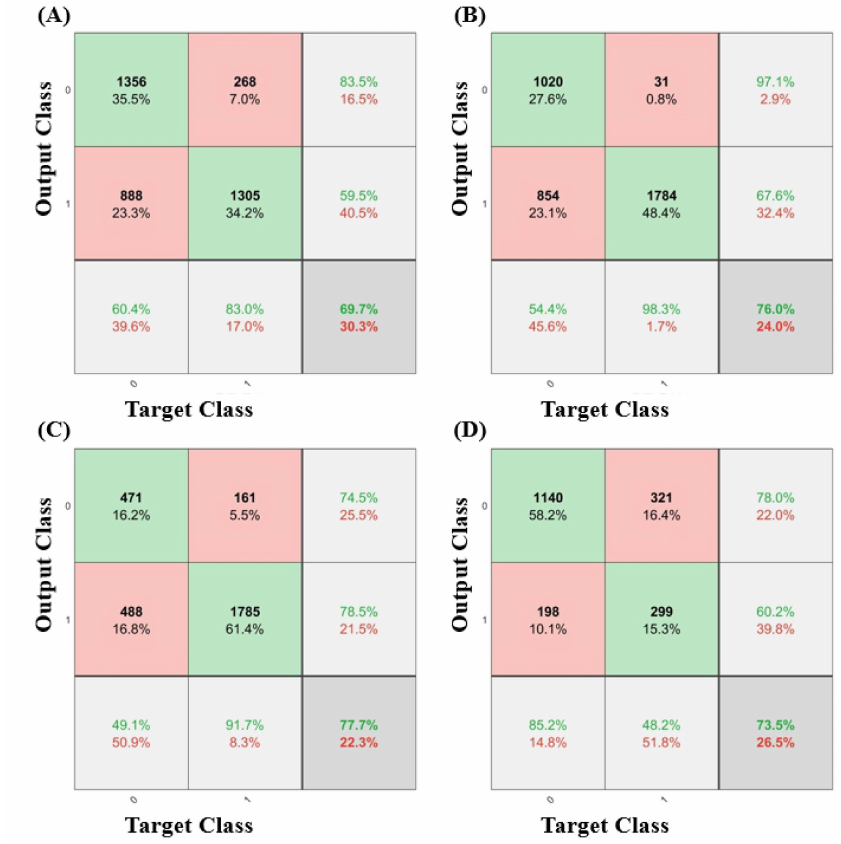
Figure 4. The confusion matrices of each prediction model for the validation data. Number 0 means lower ICP levels (<25 mmHg) and number 1 means IICP ( ≥ 25 mmHg): ( A ) Logistic regression; ( B ) Naïve Bayes; ( C ) Support vector machine; ( D ) Random